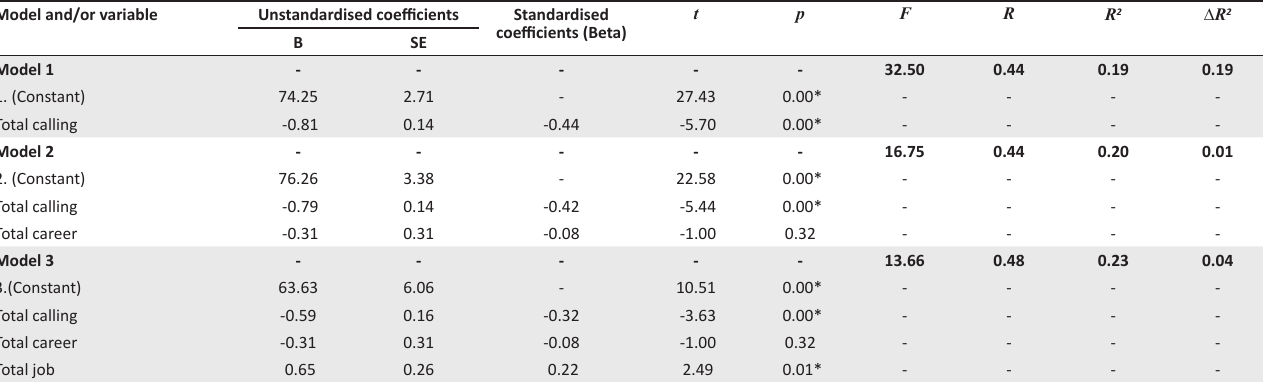
TABLE 4: Regression analyses with meaning of work (job, career or calling) as the independent variable and organisational commitment as the dependent variable. Model and/or